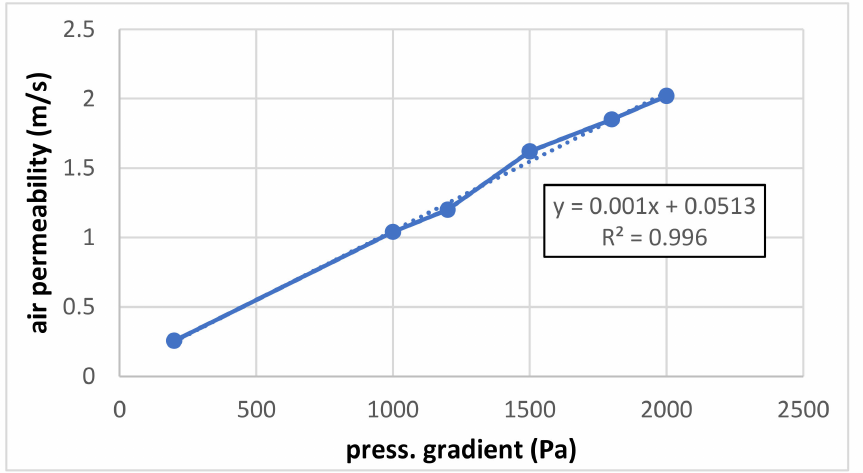
Figure 4. Air permeability for higher pressure gradients.